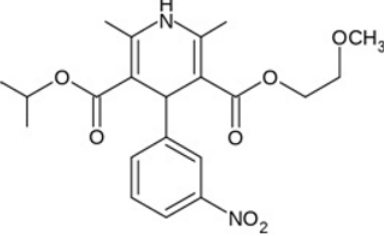
Figure 1. Chemical structure of